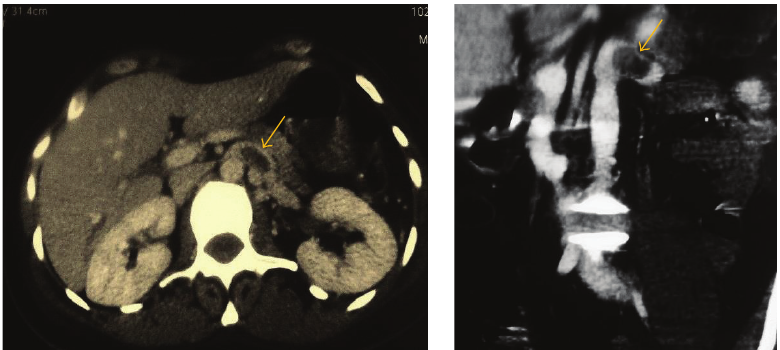
Figure 1: CT of the abdomen and pelvis demonstrating a dilated left renal vein with intraluminal thrombus (yellow arrow).